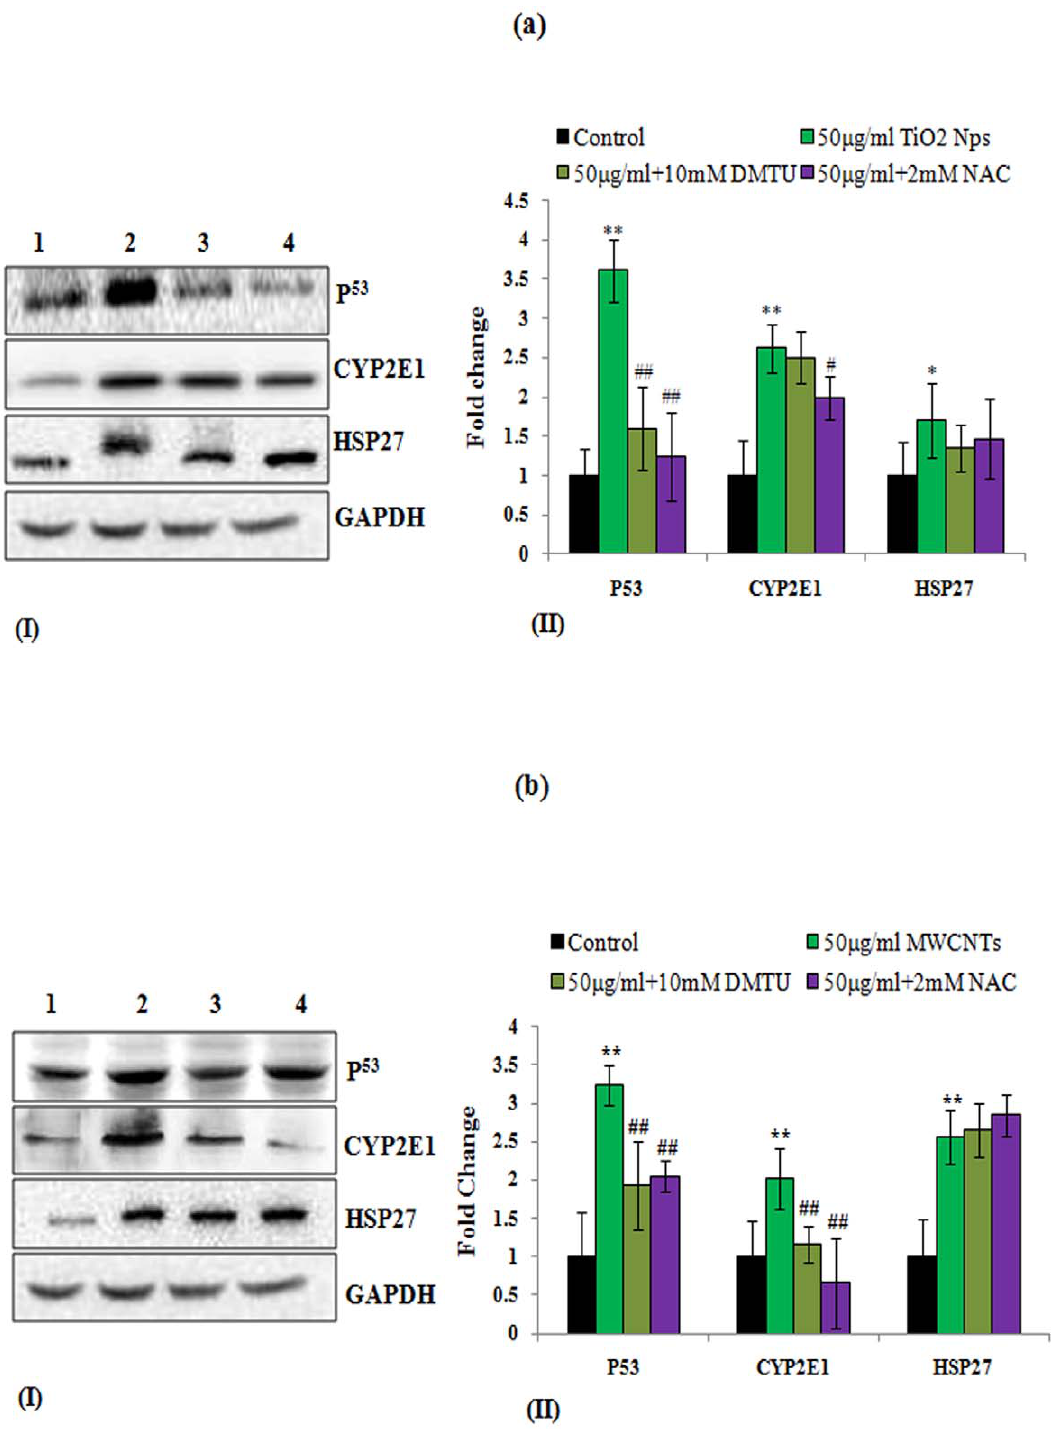
Figure 6. TiO 2 -NPs and MWCNTs (50 m g/ml) induced translational changes (HSP27, CYP2E1 and P 53 ) in the absences or presence of DMTU (10 mM)/ NAC (2 mM). a (I) Assessment of altered expressions of proteins involved in the induction of oxidative stress (HSP27 and CYP2E1) and genotoxicity (P 53 ) in A549 cells exposed to TiO 2 -NPs (50 m g/ml) for 24 h. GAPDH was used as internal control to normalize the data. Lane (1) unexposed control (2) 50.0 m g/ml TiO 2 -NPs (3) 50.0 m g/ml TiO 2 -NPs + DMTU (10 mM) (4) 50.0 m g/ml TiO 2 -NPs + NAC (2 mM). (II) Relative quantification (fold change) of proteins involved in the induction of oxidative stress (HSP27 and CYP2E1) and genotoxicity (P 53 ) in A549 cells exposed to TiO 2 -NPs for 24h. GAPDH was used as internal control to normalize the data. Quantification was done in Gel Documentation System (Alpha Innotech, USA) with the help of AlphaEase TM FC StandAlone V.4.0 software. All values are mean 6 S.E. of 3 experiments. ** P , 0.01 (unexposed control Vs TiO 2 -NPs exposure). ## P , 0.01 (TiO 2 -NPs exposure Vs DMTU/NAC treatment). b (I) Assessment of altered expressions of proteins involved in the induction of oxidative stress (HSP27 and CYP2E1) and genotoxicity (P 53 ) in A549 cells exposed to MWCNTs (50 m g/ml) for 24 h. GAPDH was used as internal control to normalize the data. Lane (1) unexposed control (2) 50.0 m g/ml MWCNTs (3) 50.0 m g/ml MWCNTs + DMTU (10 mM) (4) 50.0 m g/ml